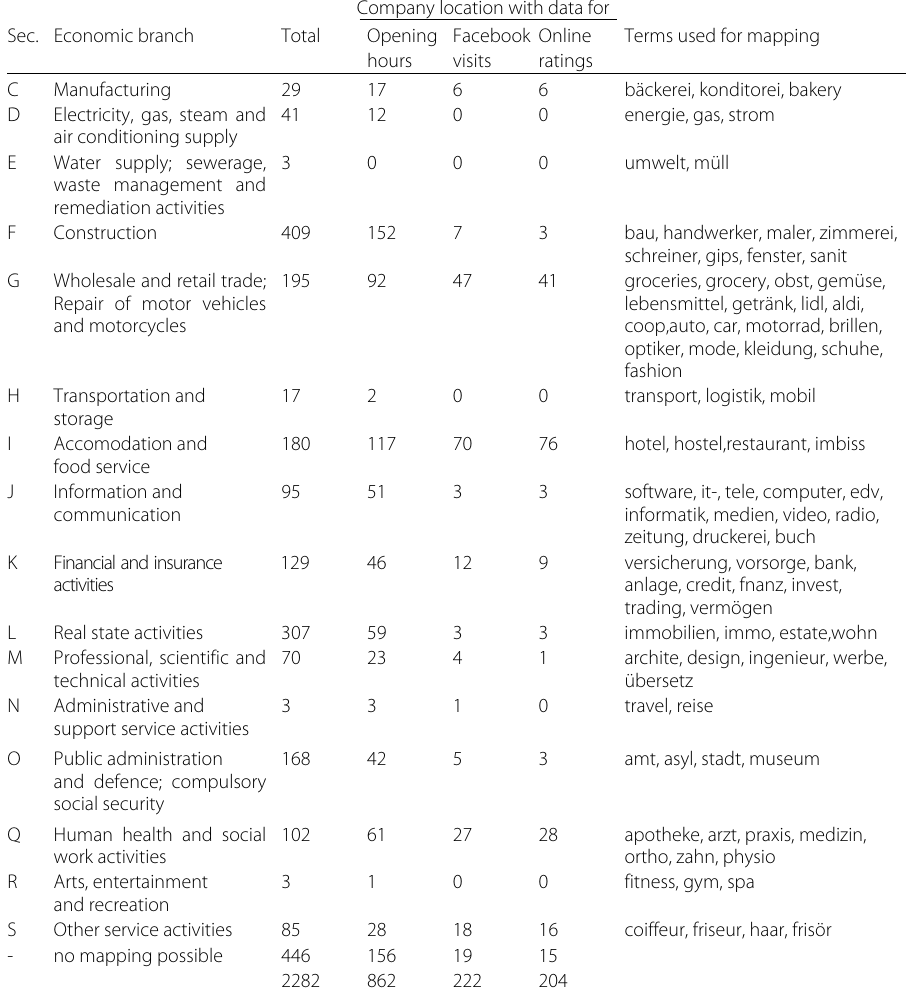
Table 1 Economic branch classification and number of companies in the dataset with the different open big data variables available Company location with data